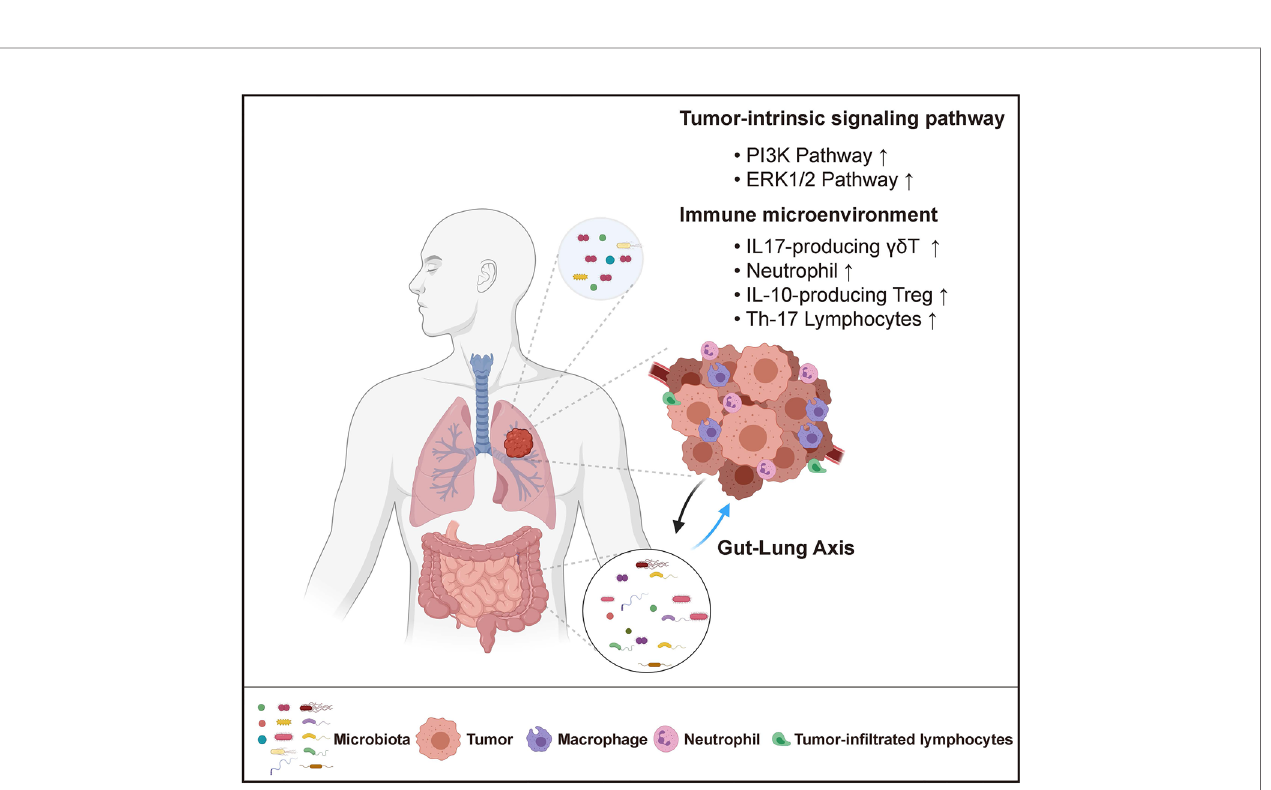
FIGURE 1 | Host-Microbiome Interaction in Lung Cancer. Both local (lung) and distal (gut) microbiota play critical roles in lung cancer. Local microbiota derived metabolites may serve as signaling molecules that directly impact tumor cell intrinsic pathways. They can also reshape the local immune microenvironment by promoting in fl ammation and inducing immune-suppression. Distal gut microbiota may affect lung tumor development through the regulation of the systemic immune